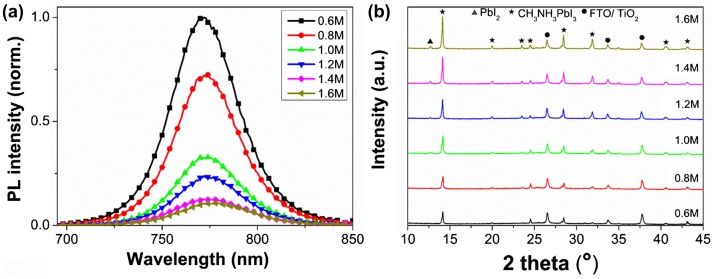
(a) Steady-state PL spectra and (b) XRD patterns of FTO/bl-TiO2/mp-TiO2 /CH3NH3PbI3 films as a function of C
(PbI2).